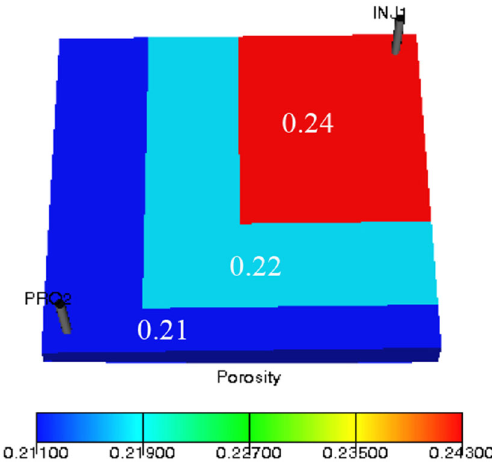
Fig. 3 Porosity model for injecting into thin layers and producing from thick ones